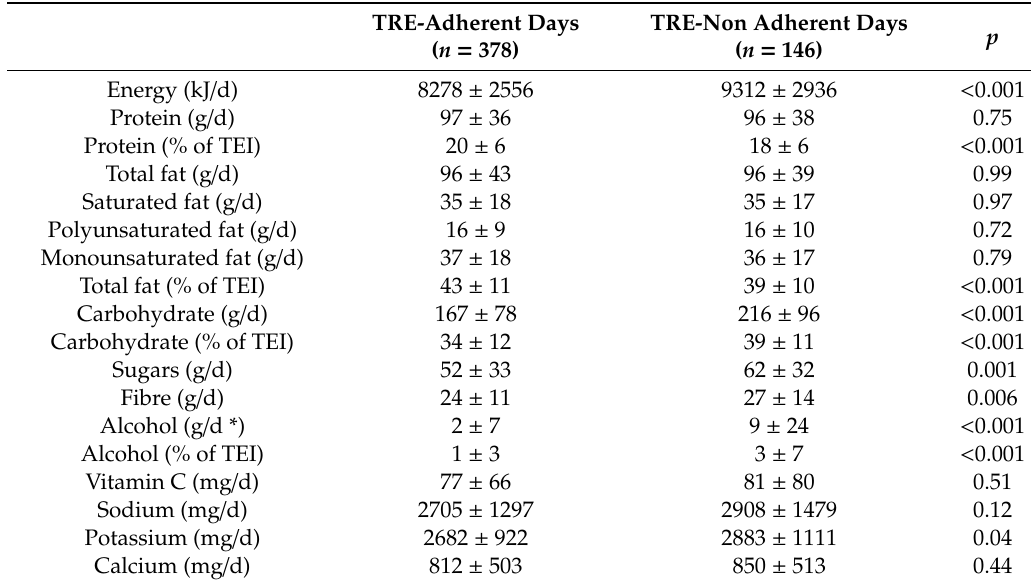
Table 4. Comparison of dietary intake for adherent and non-adherent days during the time-restricted eating (TRE) period as assessed from daily dietary food records for individuals with type 2 diabetes and overweight /